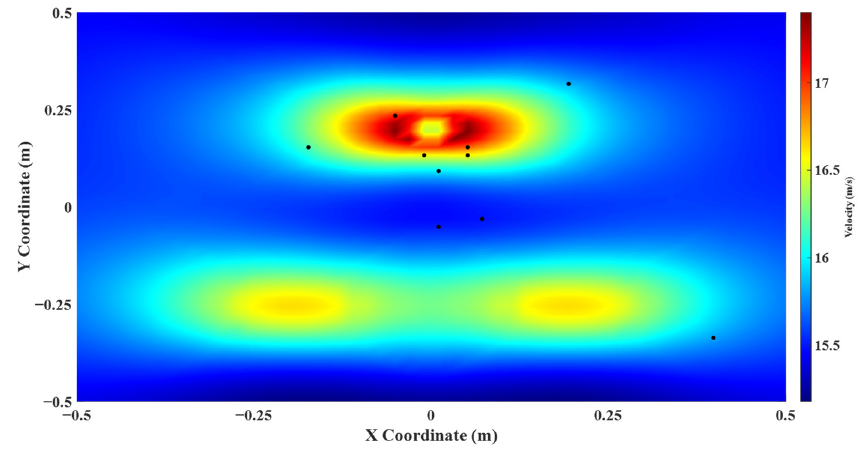
Figure 23. Reconstructed velocity nephogram (boundary condition 1) of the first plane with ten sensor positions (black points).